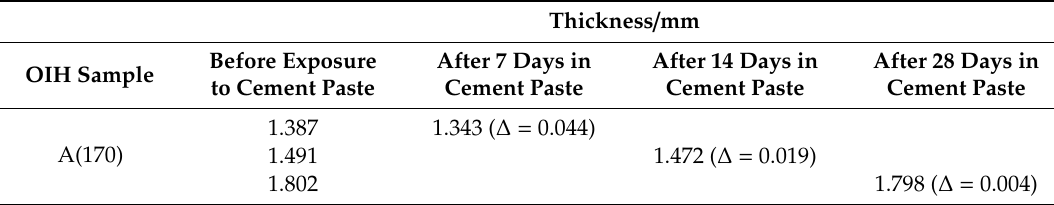
Table 3. Thickness of the OIH films measured after 7, 14, and 28 days embedded in cement paste with a w / c =